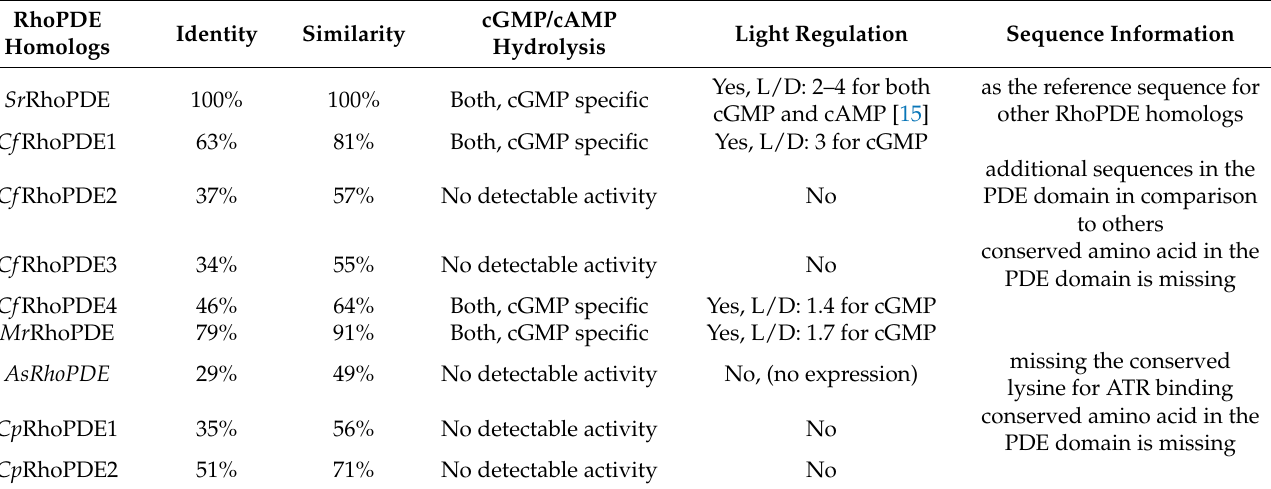
Table 2. Comparison of different RhoPDEs from